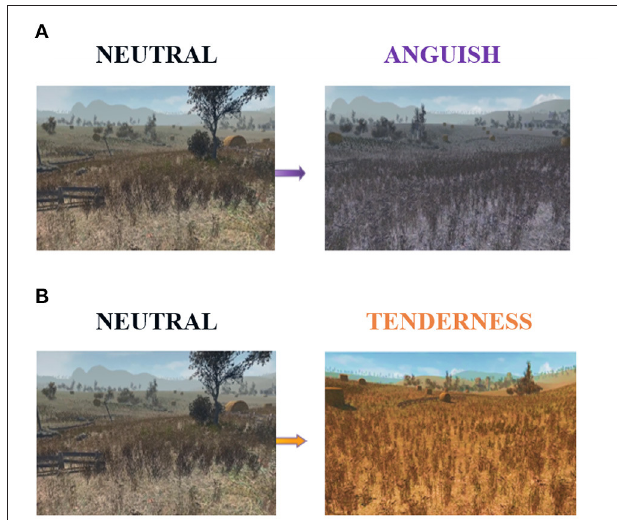
FIGURE 1 | The virtual reality scenario, which we used to induce emotions during the experiment. Compared to the neutral-colored scene on the left, the color hue of the landscape turned purple (A) for anguish trials, while for all tenderness trials, it turned into a vivid orange (B) .